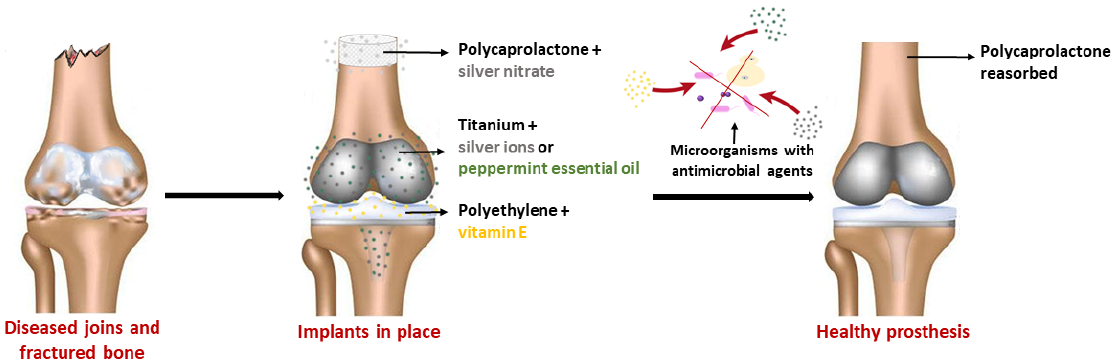
Figure 2. The development of biomaterials that incorporate antimicrobial agents—e.g., silver nitrate, peppermint essential oil, silver ions, and vitamin E—can reduce microbial adhesion (via contact- killing or release-killing modes, or both) on these surfaces, preventing implant-related infection.